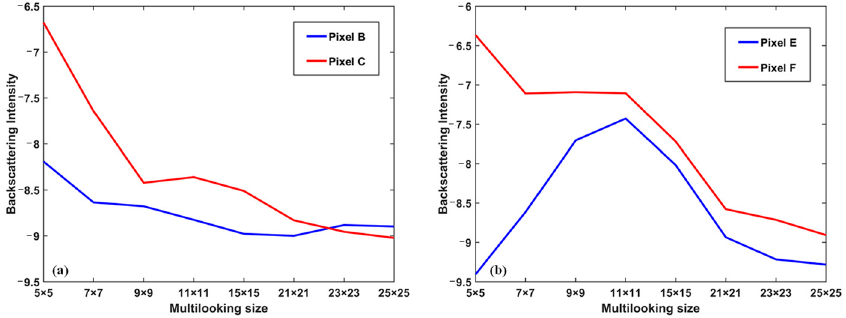
Figure 6. Backscattering intensity and spatial variations of pixels at the HH channel for different multilooking sizes: ( a ) pixel A in Mabounie; ( b ) pixel D in Mondah.